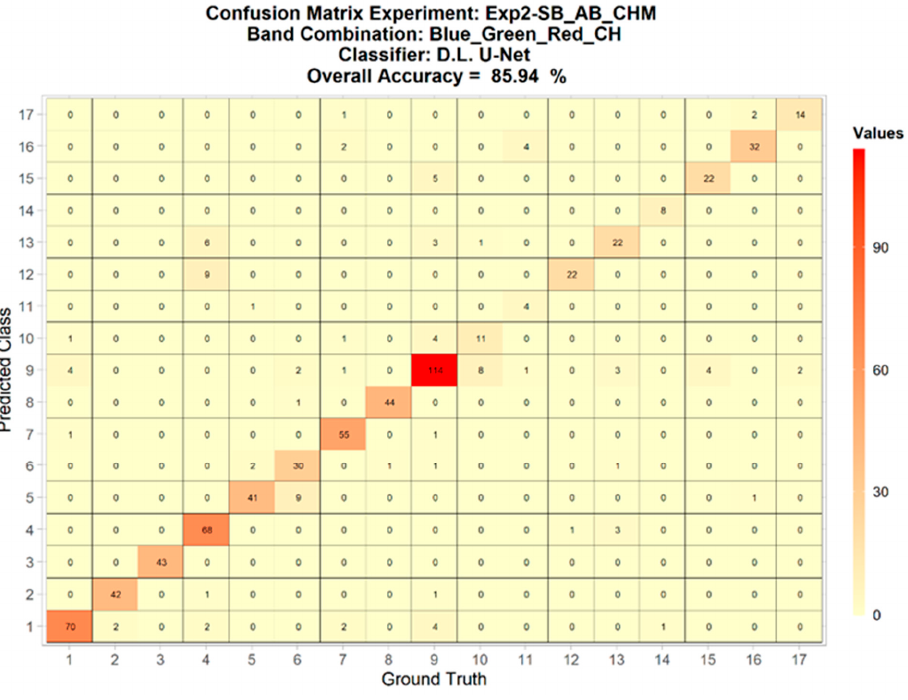
Figure A17. Confusion matrix for the best results obtained in Exp2-SB_AB_CHM, using the Deep Learning classifier with the U-Net architecture (the Green_Red_RE_CH band combination).